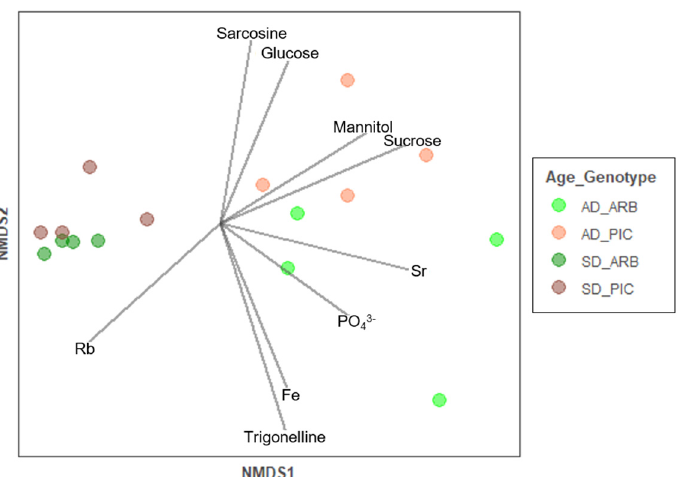
Figure 6. NMDS based on Bray-Curtis dissimilarity and environmental fitting test analysis (envfit) displaying significant chemical variables ( p < 0.05) explaining bacterial ASV distribution in olive xylem sap of plantlets (SD) and adult (AD) olive trees of ‘Picual’ (PIC) and ‘Arbequina’ (ARB) genotypes.